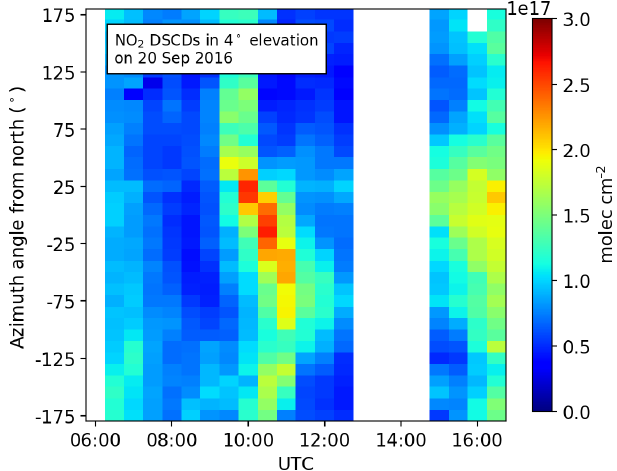
Figure 11. Geometry of transport event. The blue arrow indicates the plume’s trajectory s . The mean wind direction on 20 Septem- ber 2016 is 75 ◦ . The black dashed line is the closest distance r be- tween the instrument (in the origin of the coordinate system) and the trajectory, which is perpendicular to the trajectory and divides it into s 1 and s 2 . The plume appears at 10:00UTC under the azimuth angle β 1 and at 11:00UTC under β 2 (with respect to north). γ 1 and γ 2 are the respective angles relative to the direction of closest dis- tance ( r ) instead of